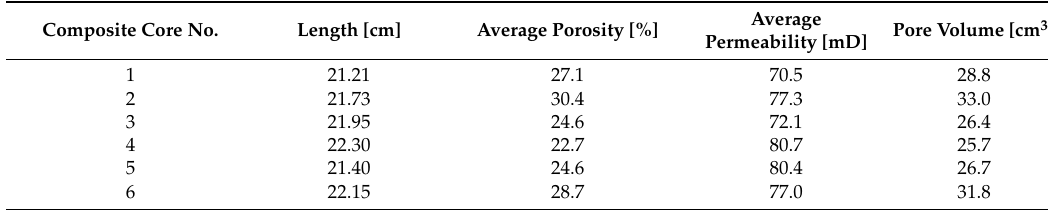
Table 4. Properties of composite cores.